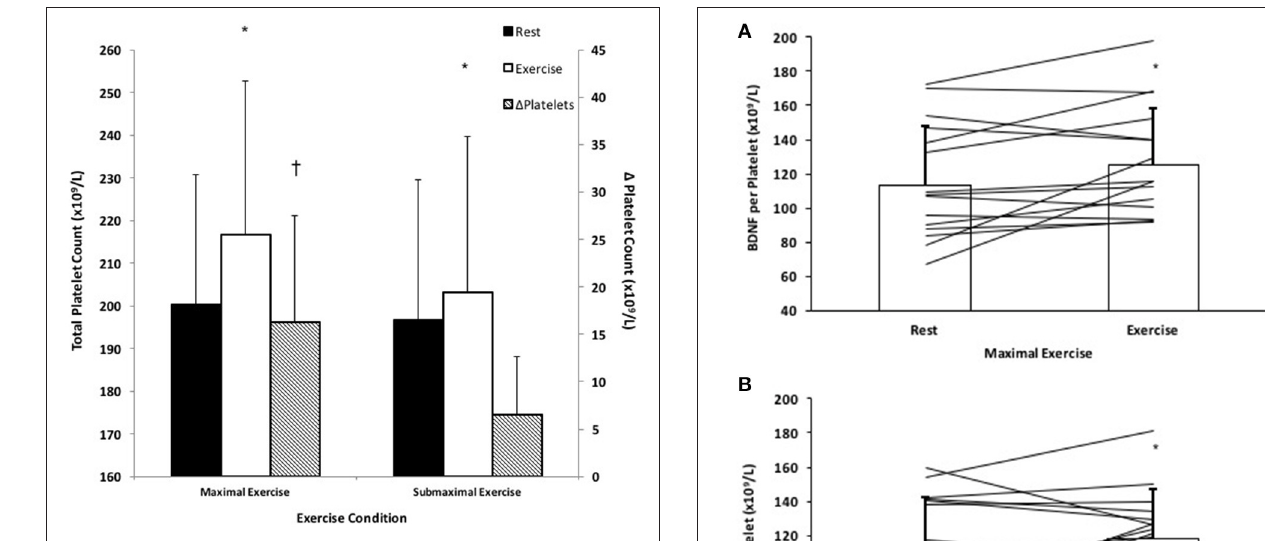
FIGURE 2 | Platelet responses to small muscle mass exercise. Total platelets at rest (black bars) and total platelets during exercise (white bars) correspond with the left y-axis. 1 Platelets represents the difference between exercise and rest platelets (hatched bars) and corresponds with the right y-axis. *Significantly different compared to rest, p < 0.05. † Significantly different compared to SE, p < 0.05.